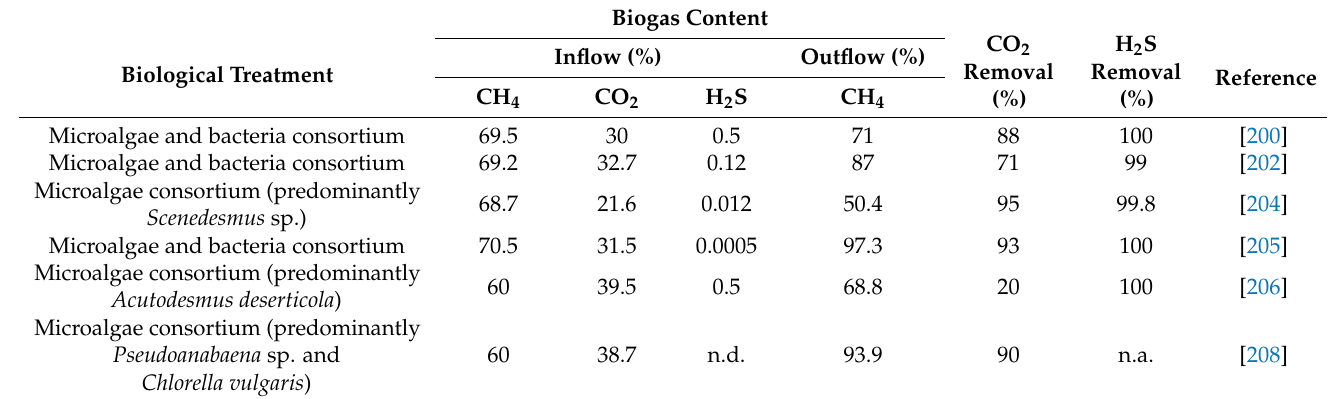
Table 5. Biogas upgrading using microalgae-based biological